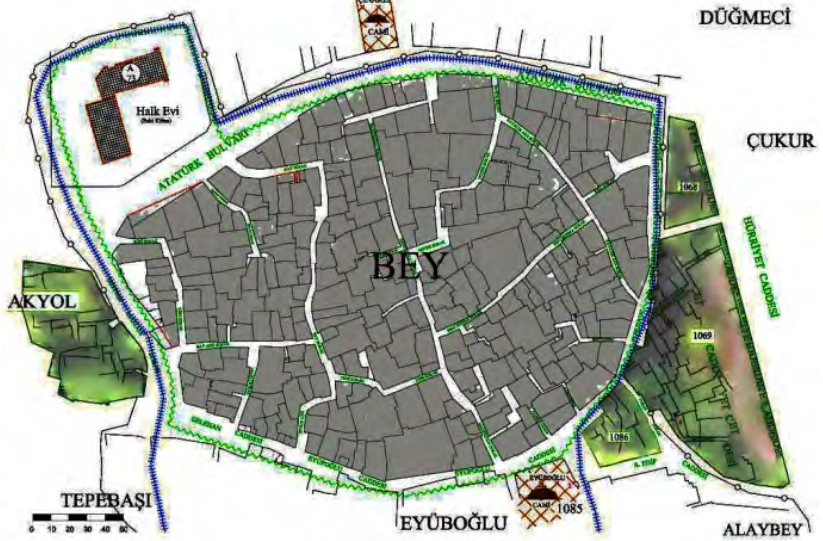
Figure 4. Bey neighborhood urban